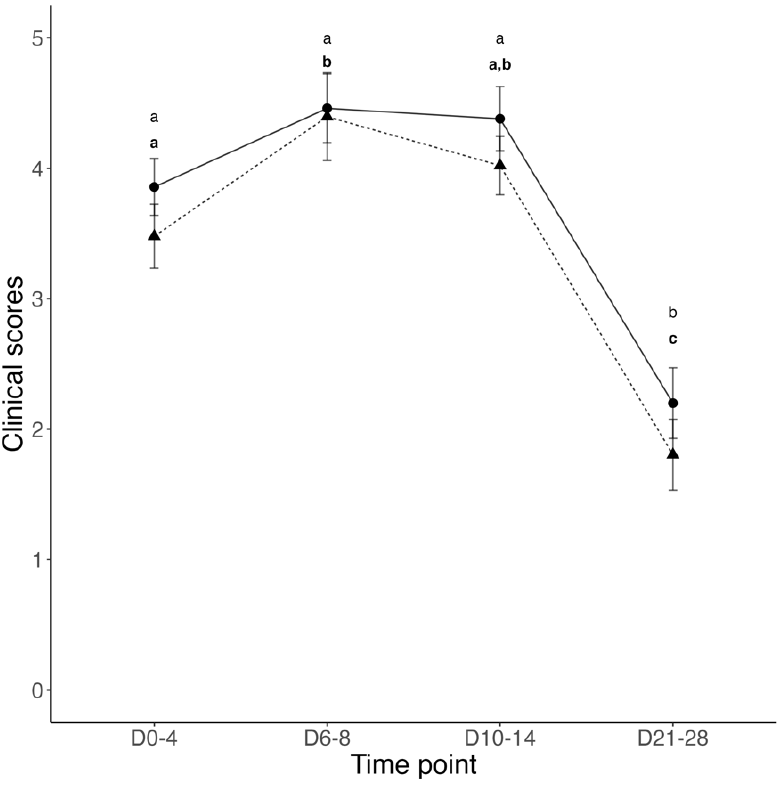
Figure 1. Mean ± SEM total respiratory scores on days 0 to 4, 6 to 8, 10 to 14, and 21 to 28 after challenge of calves vaccinated intranasally (IN) with a modified-live virus (MLV) BRSV vaccine in the first 6 h of life (dashed line and triangles) versus control calves (solid line and circles) subsequently challenged with BRSV. For each group and time point, the circle or triangle represents the mean, and the whiskers represent the SEM. A line for each group connects the group’s mean total respiratory score (on a scale of from 0 to 5 [none or mild respiratory disease] to >10 [severe respiratory disease]) progression throughout the study. Data were analyzed using generalized mixed-effects models. Distinct letters (small caps a, b, c) represent significant ( p < 0.05) difference between time-points within participants of each group (Vacc in bold).